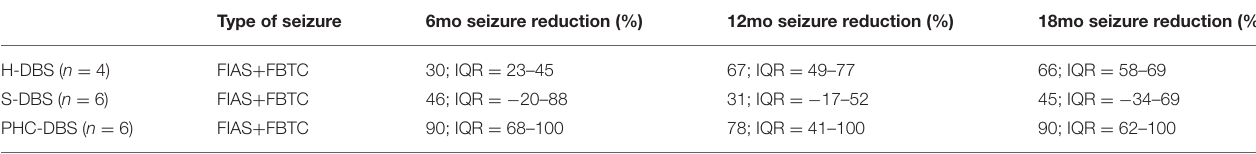
TABLE 2 | Comparative seizure outcome and complications of patients with hippocampal sclerosis treated by DBS in the H, S, PHC.